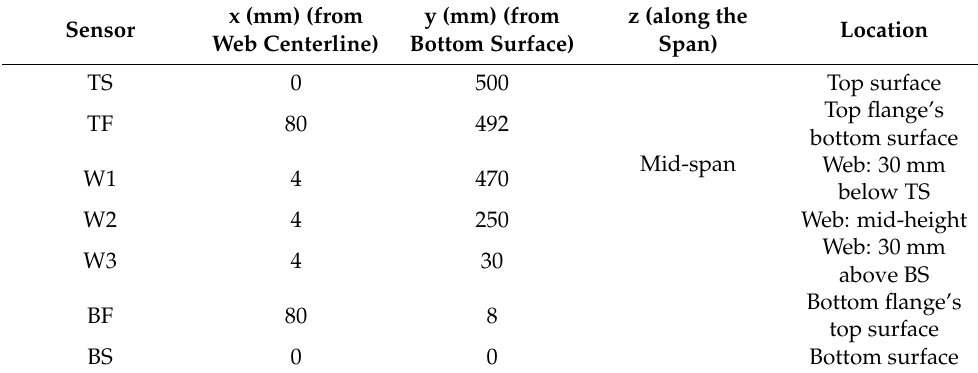
Table 1. Sectional locations of virtual